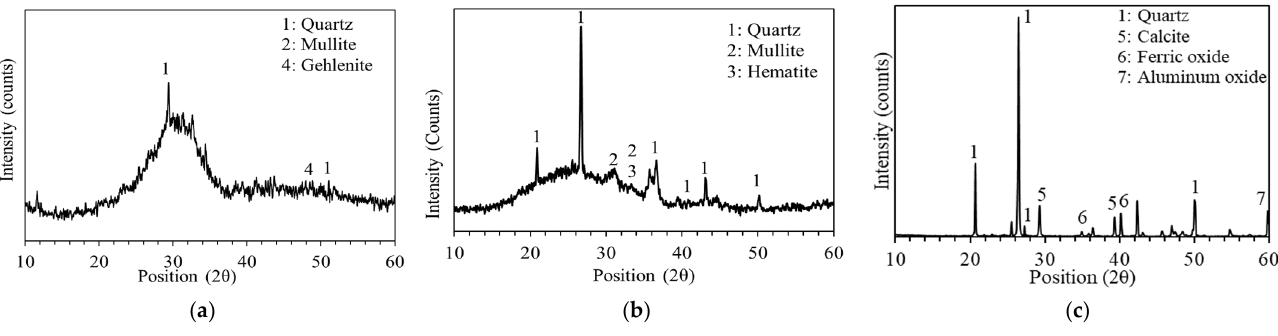
Figure 2. SEM micrographs of ( a ) slag, ( b ) fly ash, and ( c ) dune sand.